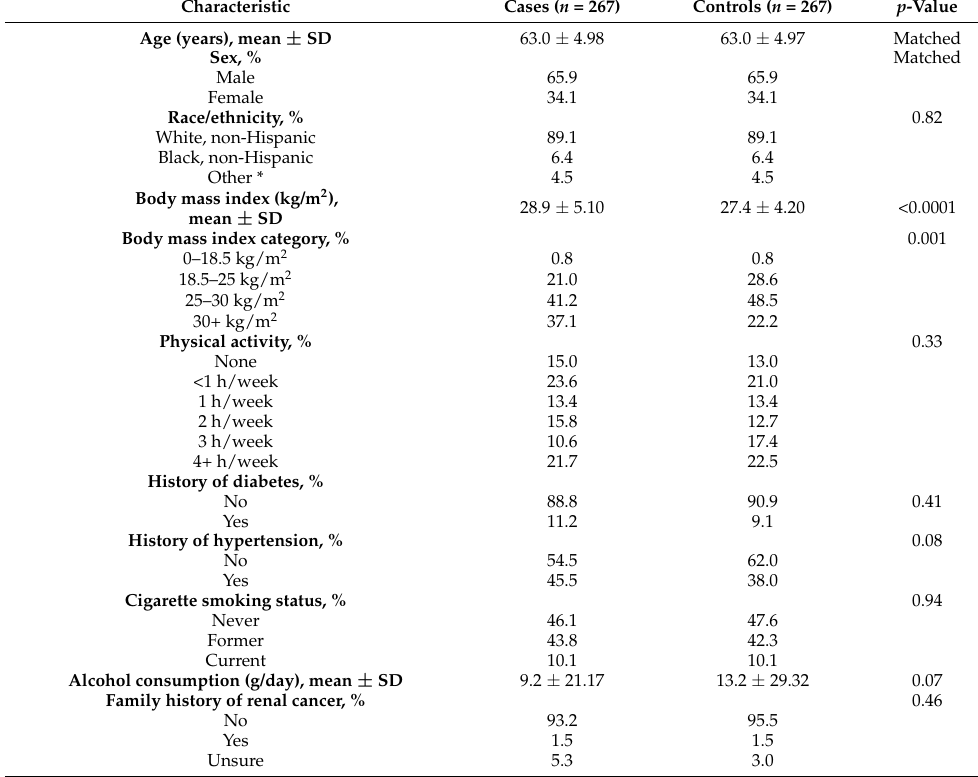
Table 1. Sociodemographic, lifestyle, and medical history characteristics of the renal cell carcinoma case–control study nested within the Prostate, Lung, Colorectal, and Ovarian Cancer Screening Trial. Characteristic